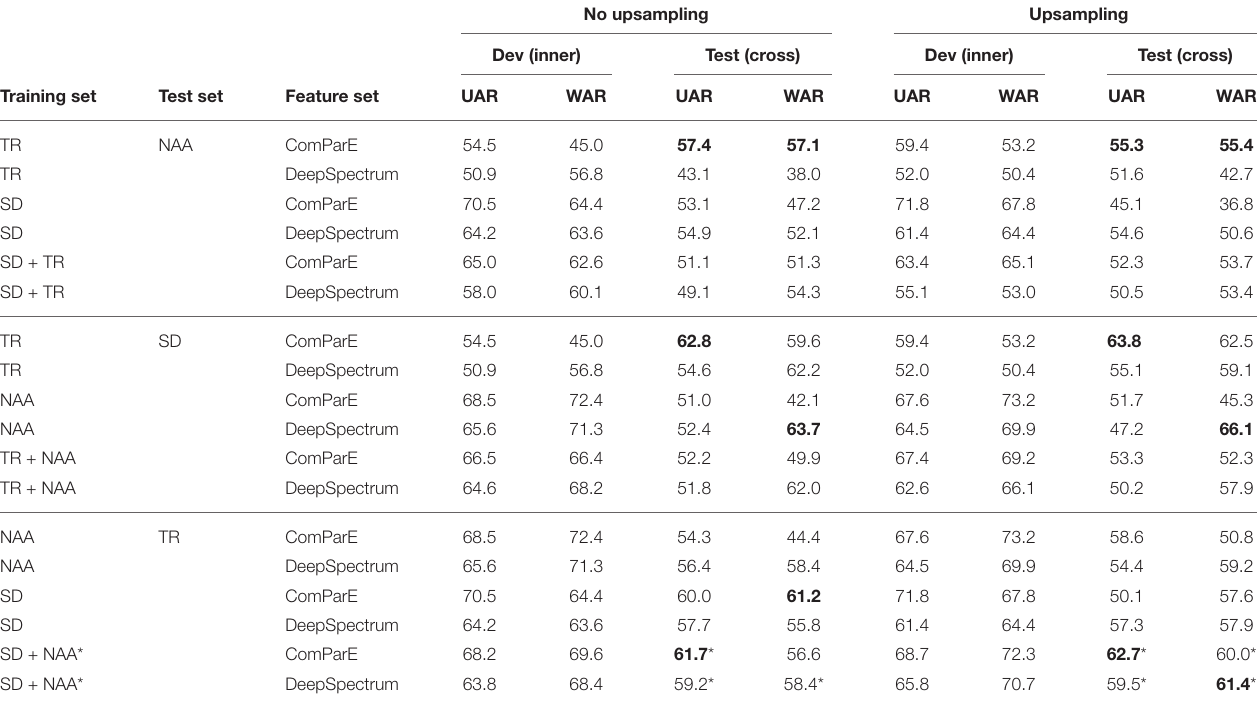
TABLE 4 | Results obtained for all corpora combinations for both ComParE and DeepSpectrum feature sets using the NAA N-A label. No upsampling Upsampling Dev (inner) Test (cross) Dev (inner) Test